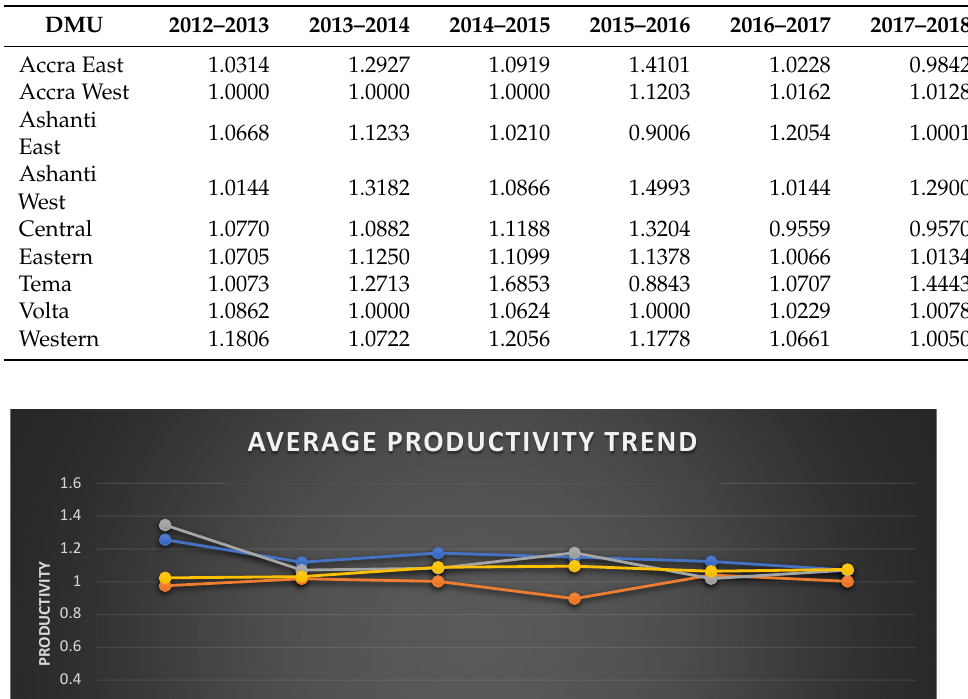
Table 2. Static Productivity of EDRs.